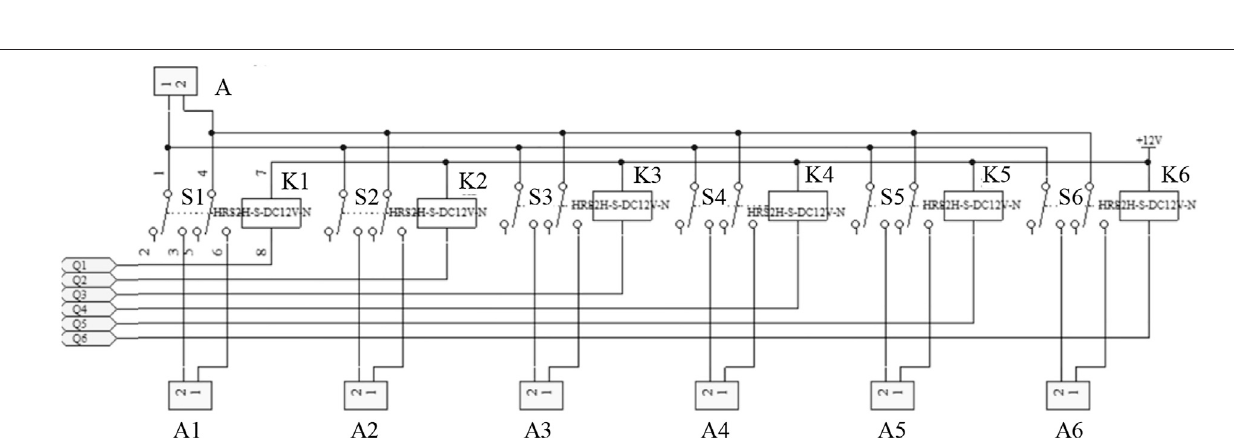
FIGURE 2 | Multi-channel selector connection